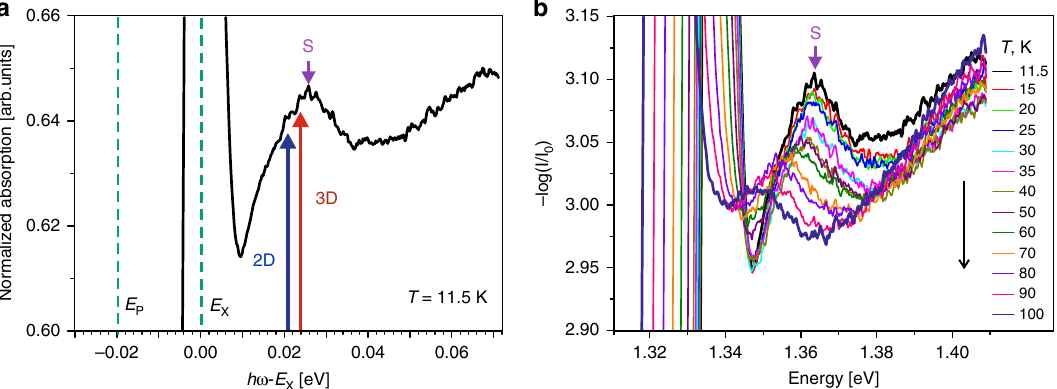
Fig. 4 Sommerfeld peak. a An absorption spectrum measured at 11.5 K normalized to the intensity of the X peak, whose energy is taken as zero. The vertical axis scale is chosen to focus on the Sommerfeld peak (S). The bandgap energies derived from the P-band analysis are shown for the 3D (red arrow) and 2D allowed (blue arrow) cases. The peaks of excited states are not resolved. b The absorption coef fi cient measured at different